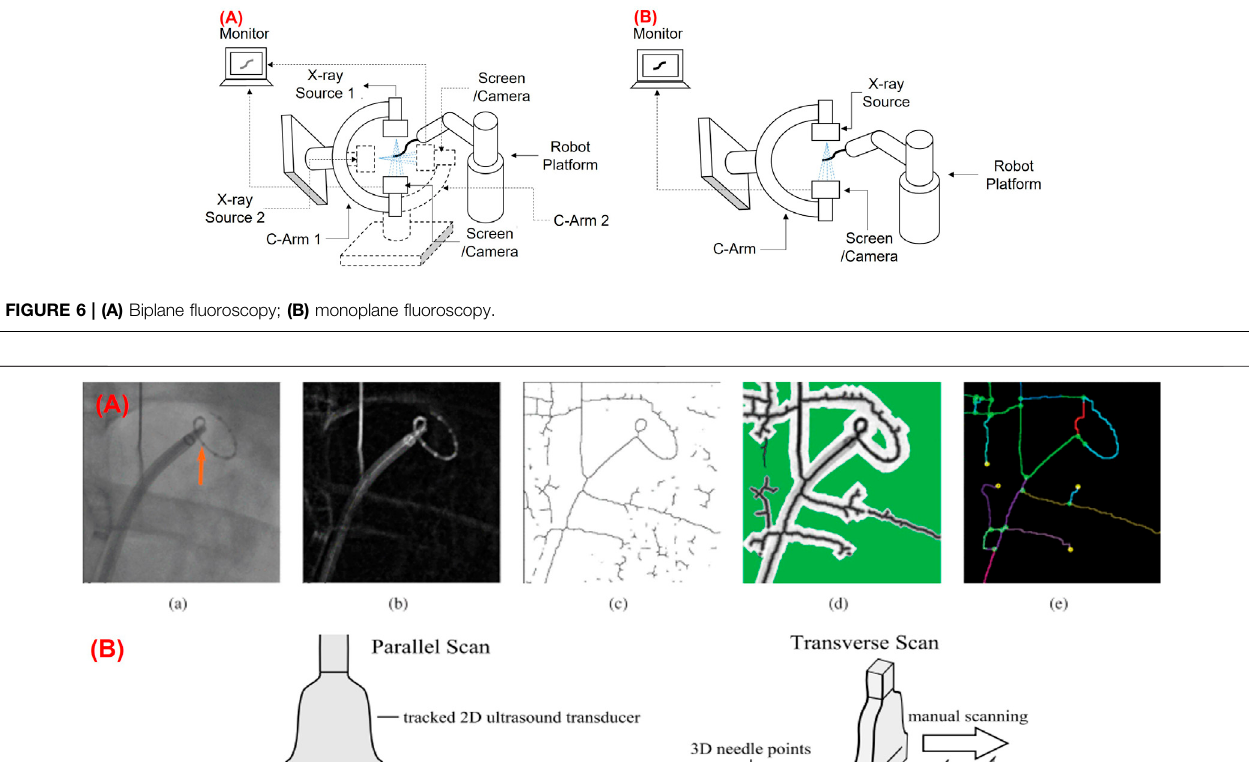
Frontiers in Robotics and AI |